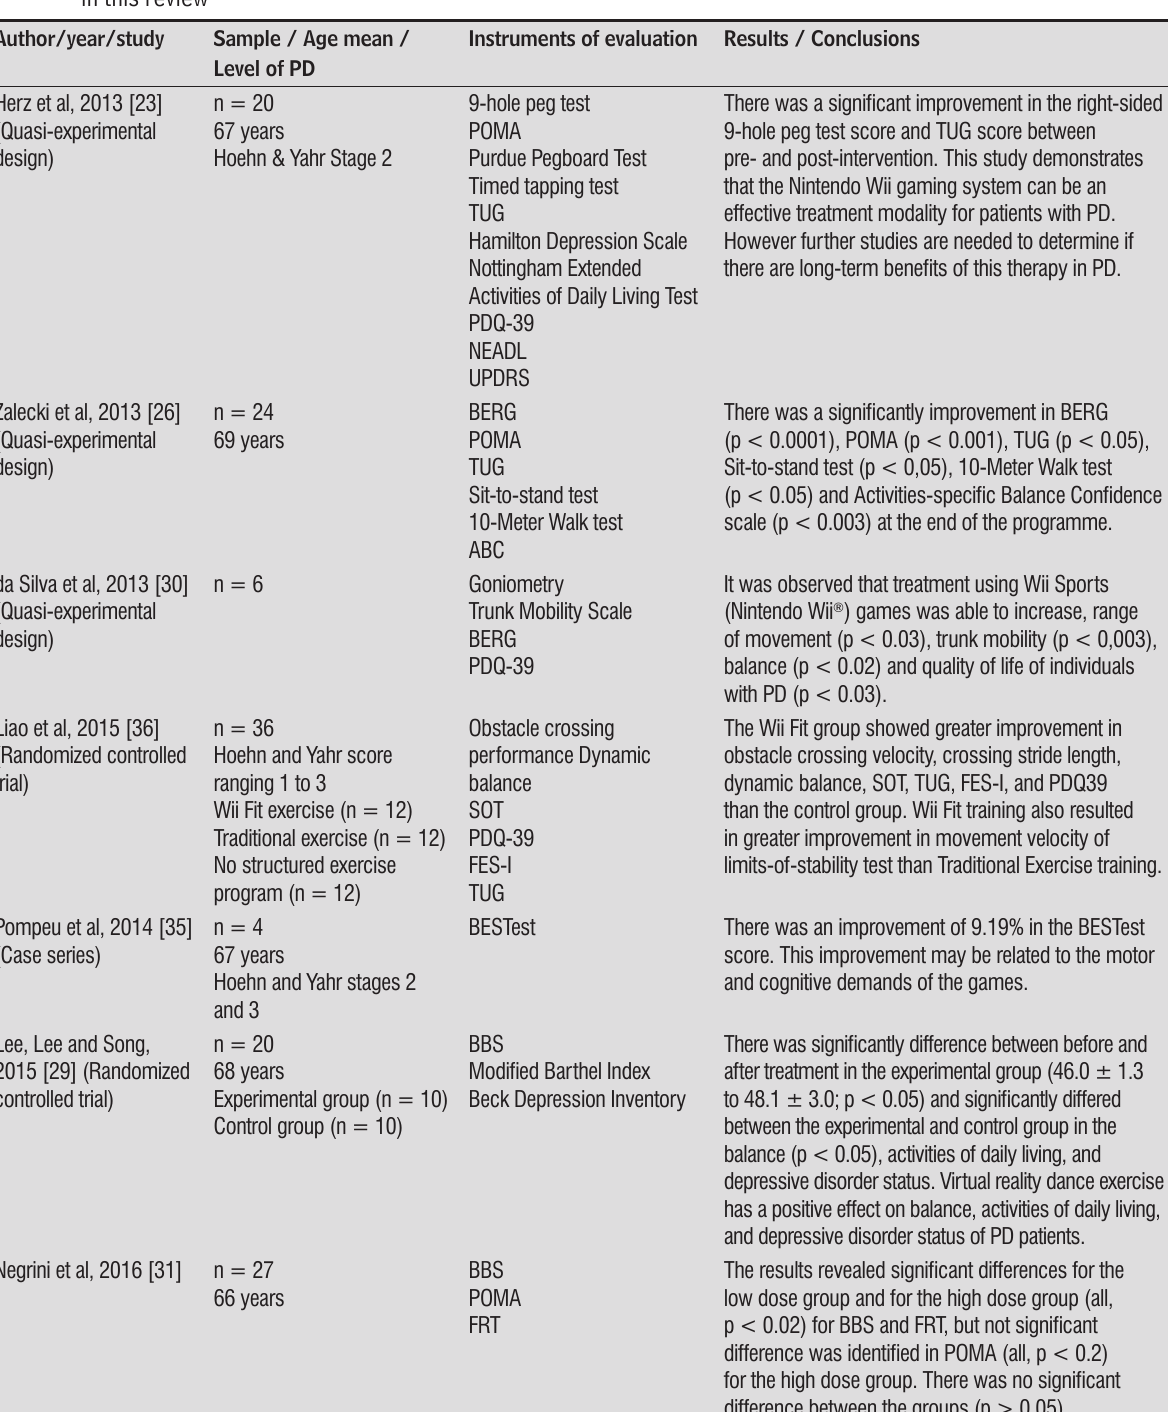
Table 3 - Characteristics of the variables and the outcome of treatment with Nintendo Wii in experimental studies included in this